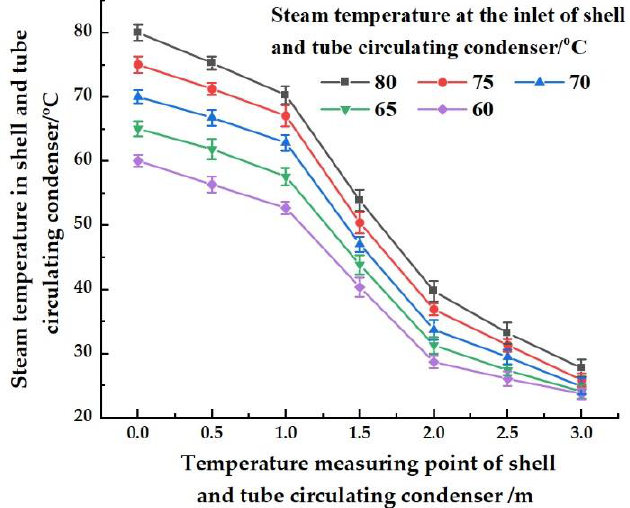
Figure 5. Temperature drop effect of the shell-and-tube circulating condenser.